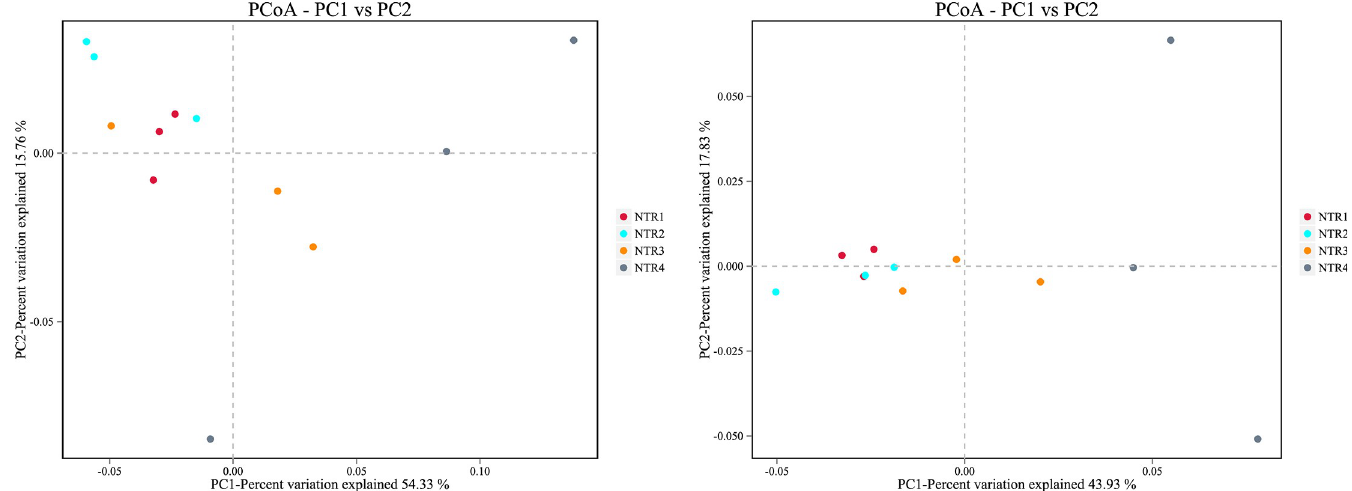
Fig 4. Summary of principal coordinate analysis of soil bacterial composition after different no tillage and crop residue mulching treatments based on the (a) weighted and (b) unweighted UniFrac distances. NTR1, no tillage and all crop residue removed; NTR2, no tillage and 30% crop residue mulching; NTR3, no tillage and 60% crop residue mulching; NTR4, no tillage and all crop residue mulching.